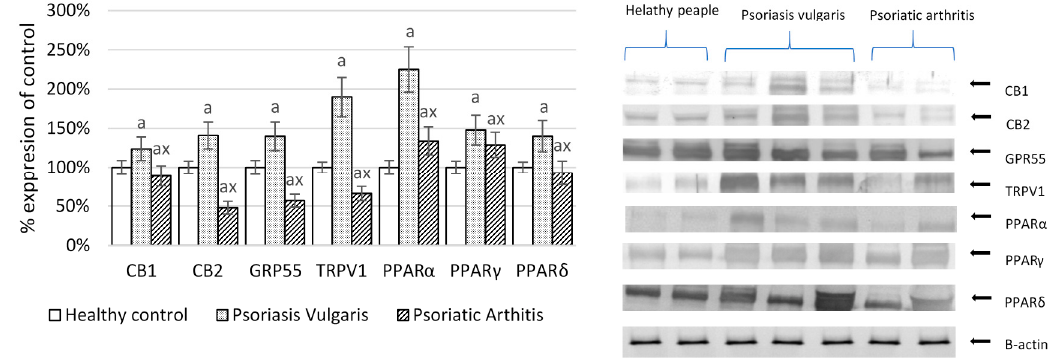
Figure 4. The expression of receptors involved in phospholipid metabolism in mononuclear cells of patients with psoriasis vulgaris (n = 16) and psoriatic arthritis (n = 8) and healthy peoples (n = 8). CB1, CB2, cannabinoid receptors; GRP55, G protein-coupled receptor 55; TRPV, the transient receptor potential cation channel subfamily V member 1; PPAR, peroxisome proliferator-activated receptor. Data points represent the mean ± SD; a, significantly different from healthy subjects, p < 0.05; x, significantly different from patients with psoriasis vulgaris, p < 0.05.